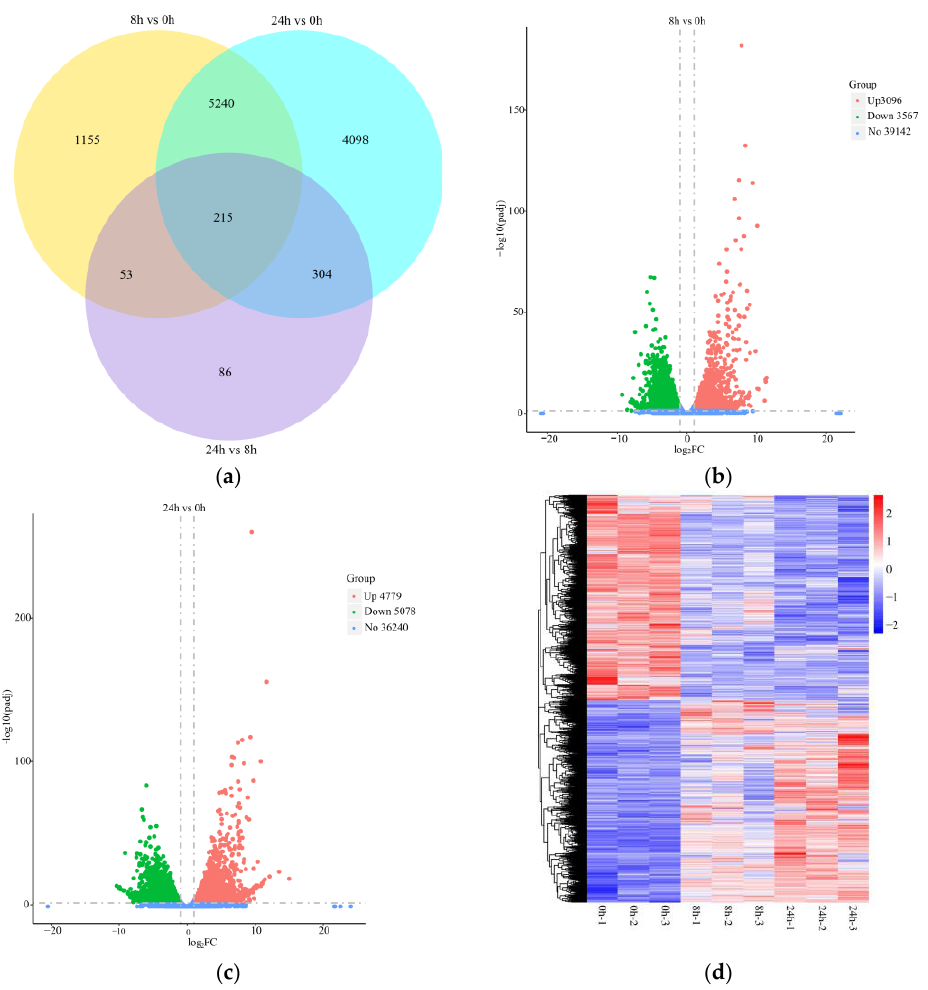
Figure 2. Statistical analysis of the number of differentially expressed genes (DEGs) and expression pattern in the roots of orchardgrass under submergence stress. ( a ) Venn diagram of the number of DEGs. Volcanic map of up- and down-regulated genes for 8 h vs. 0 h ( b ) and 24 h vs. 0 h ( c ). ( d ) Cluster heat map of DEGs was shared in all treatment groups.